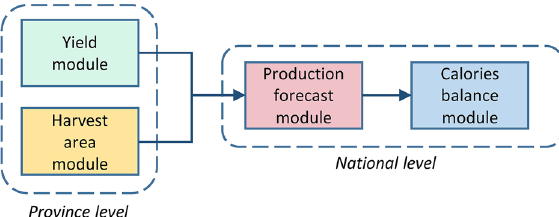
Figure 4. Work flow.